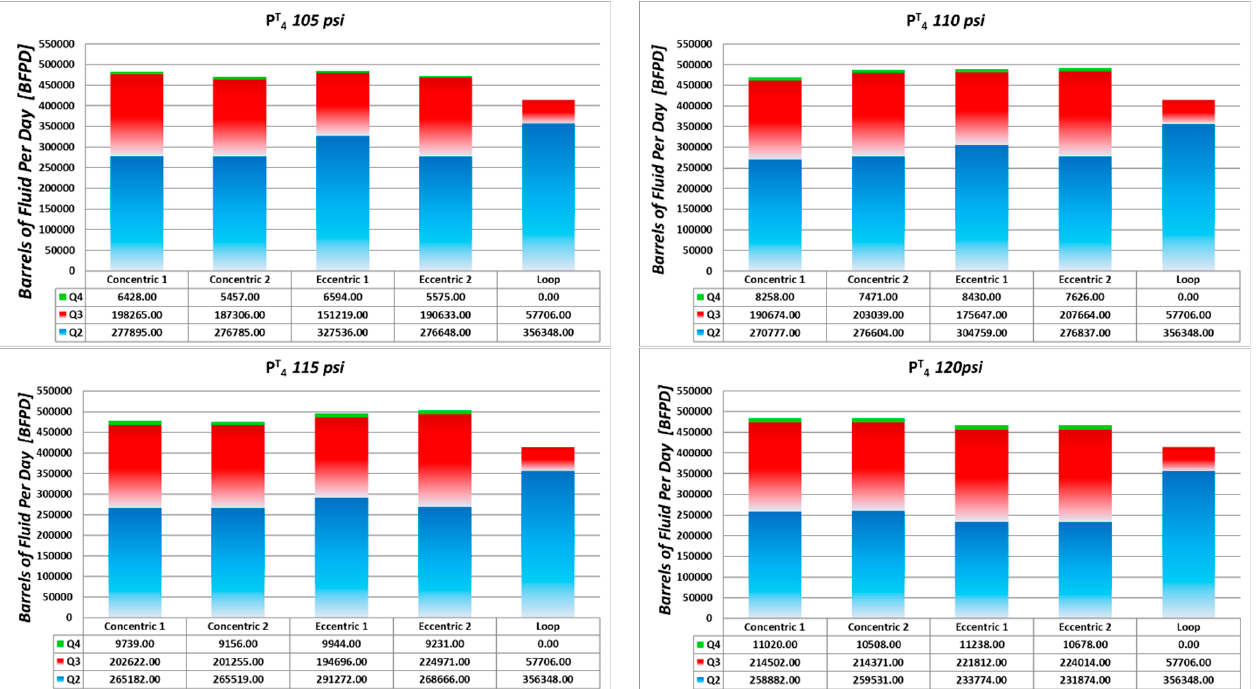
Figure 20. Flowrate for concentric and eccentric pumps. Case of study Quifa Field.